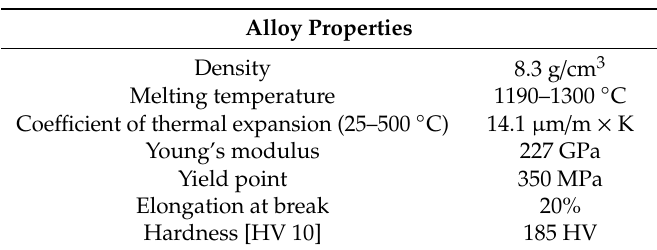
Table 2. Heraenium ® NA alloy properties.